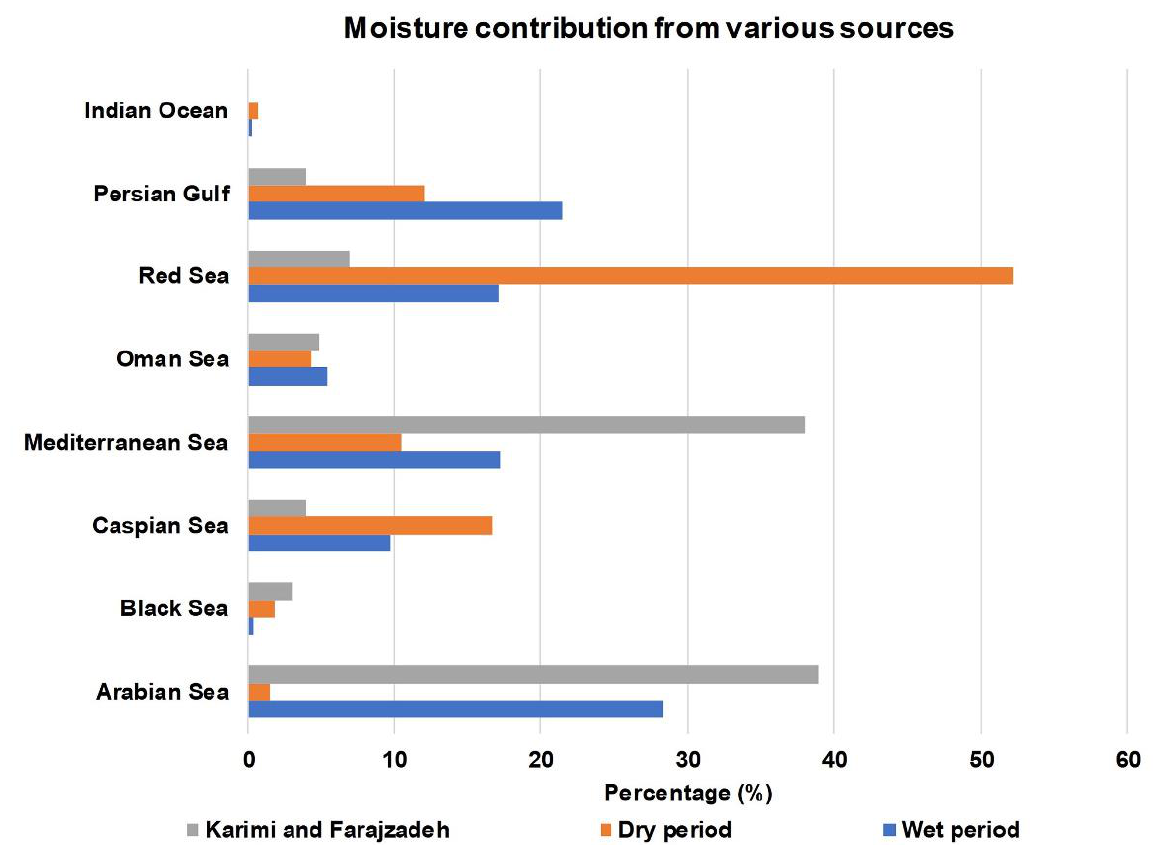
Figure 1. Percentage contribution of various moisture sources to precipitation in Iran during the wet and dry periods [7,12].